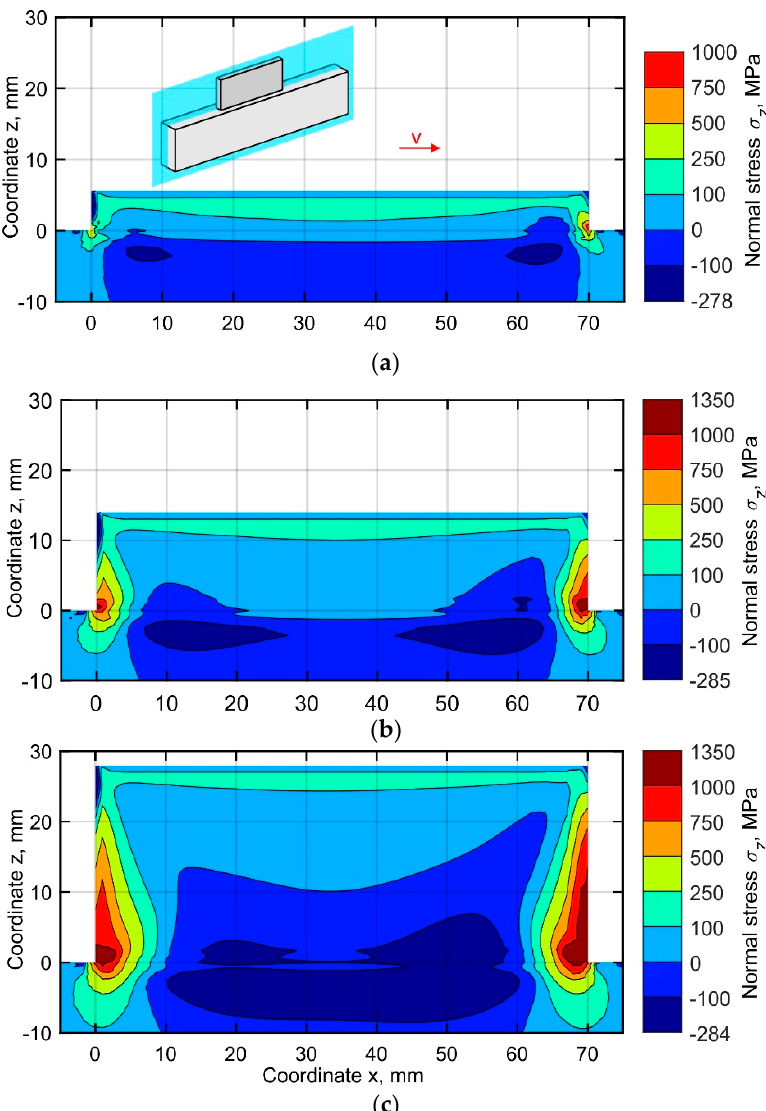
Figure 8. Longitudinal stress distribution in the central longitudinal-section of the buildup at the time corresponding to the end of the cooling after ( a ) 10, ( b ) 25 and ( c ) 50 layers.